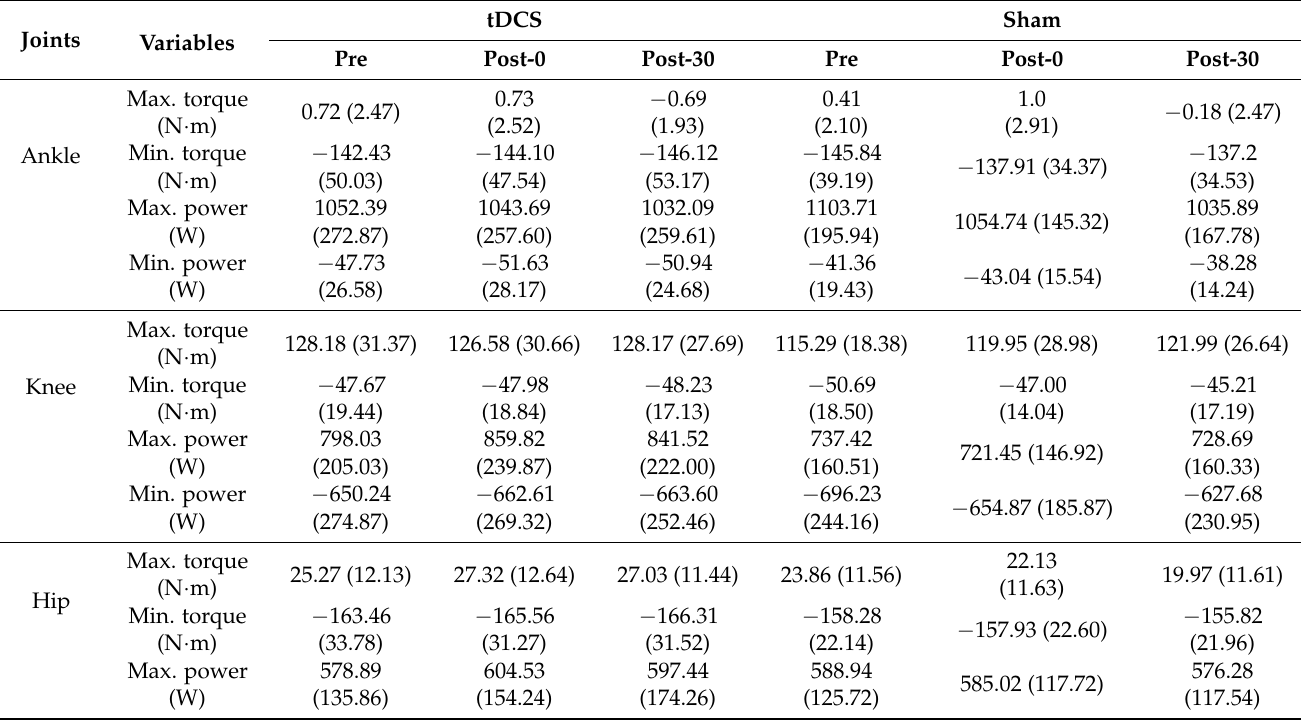
Table 3. Kinetics of lower extremities in CMJs ( N = 15, Mean